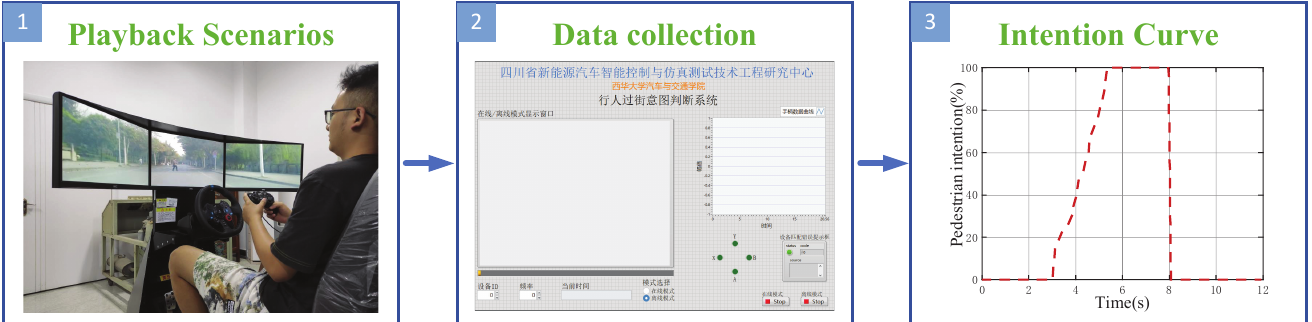
Figure 2. The manual pedestrian intention judgment